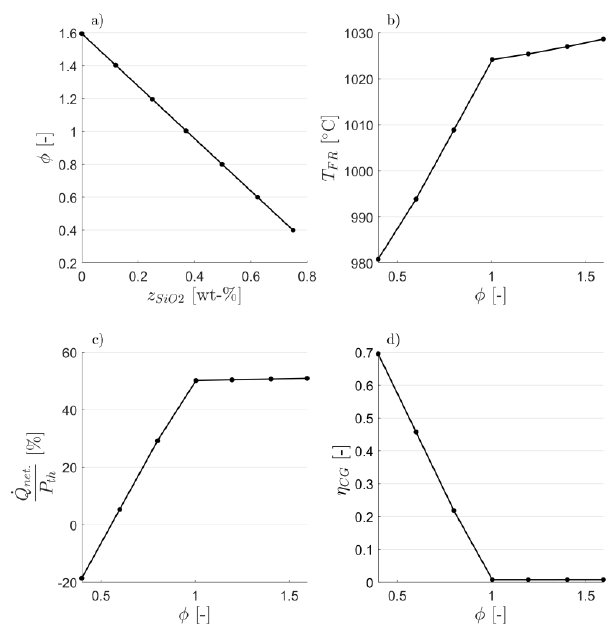
Figure 7. Simulation results for CLG operation through OC dilution with inert SiO 2 sand. OC-to-fuel ratio as a function of the inert concentration of the circulating solid mixture ( a ). Fuel reactor temperature ( b ), relative net process heat ( c ), and cold gas efficiency ( d ) for different values of 𝜙 ( 𝜆 = 1.2, 𝑚̇ 𝑂𝐶 + 𝑚̇ 𝑆𝑖𝑂2 = 𝑐𝑜𝑛𝑠𝑡 ).